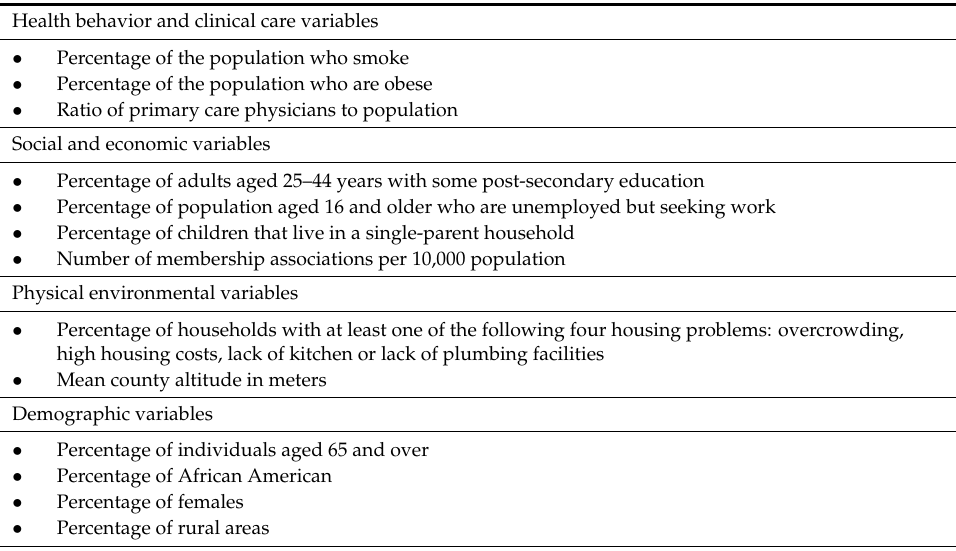
Table 1. List of independent variables.